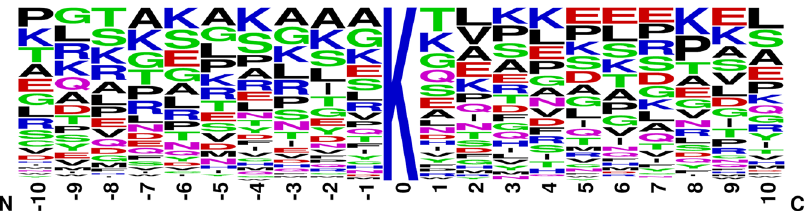
Figure 1. Frequency of amino acids in each position of SIRT1 substrates. The height of symbols within the stack indicates the relative frequency of each amino at that